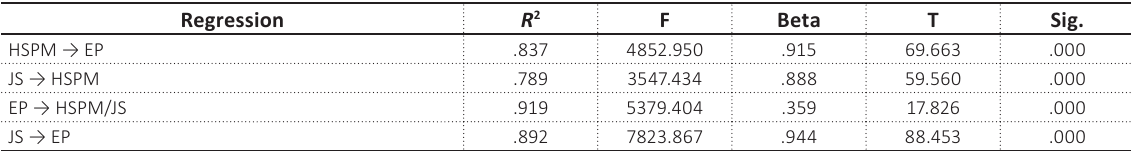
Table 6. Summary of regression results for the variables